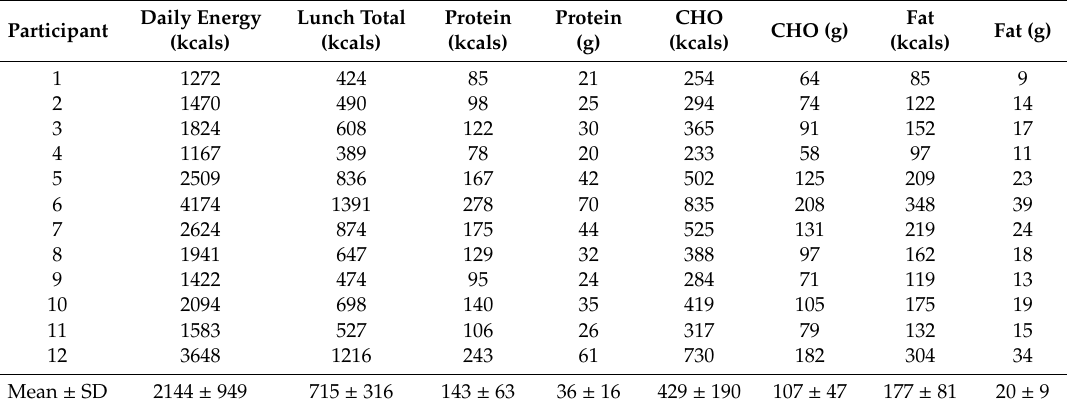
Table 2. Individual breakdown of energy and macronutrient intake for each test meal.